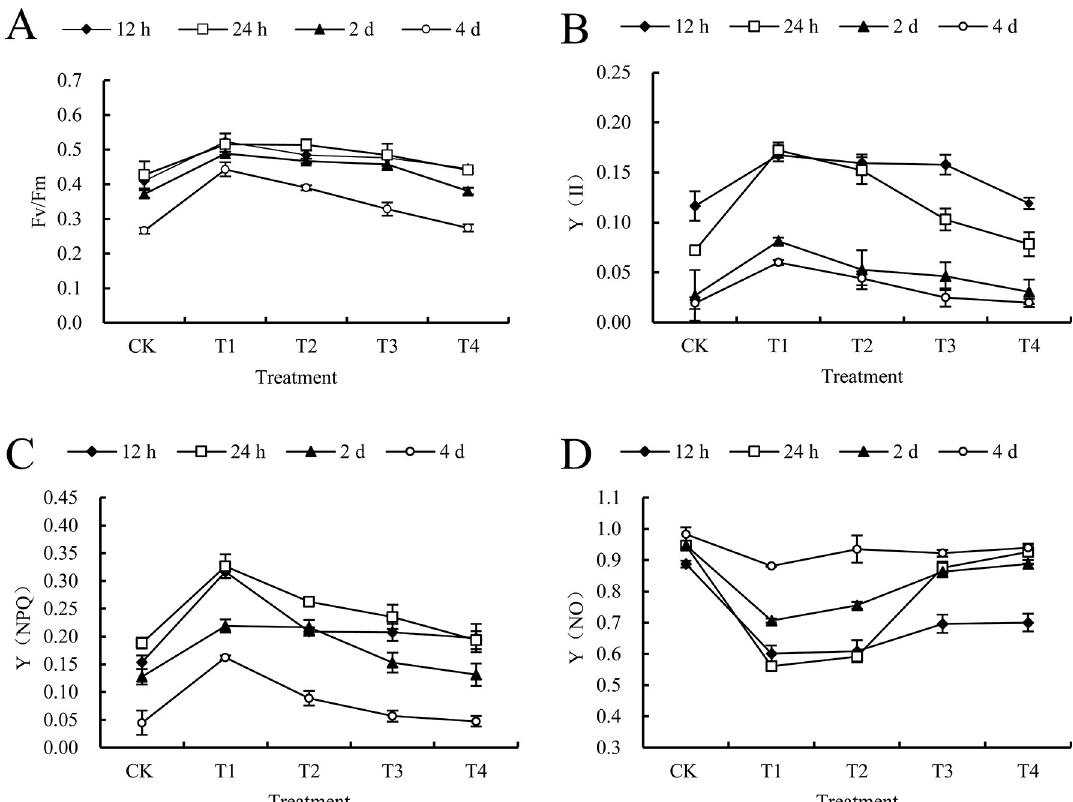
Fig 2. Effect of 2 mm/h rain intensity on chlorophyll fluorescence parameters of C . album treated by mesotrione. CK and T1, T2, T3, T4 on the x-axis represent no rain and different rainfall interval times (0.5 h, 1 h, 2 h, and 4 h) respectively; y-axis represents chlorophyll fluorescence parameters. Diamonds, squares, triangles and circles represent different times after treatment (12 h, 24 h, 2 d and 4 d, respectively). A) the maximum photochemical quantum efficiency (Fv/Fm); B) the actual photochemical quantum yield Y(II); C) the regulated energy dissipation quantum yield Y(NPQ); D) the non-regulated energy dissipation quantum yield Y(NO) of C . album treated by mesotrione. Lowercase letters in the same column indicate significant differences at the 0.05